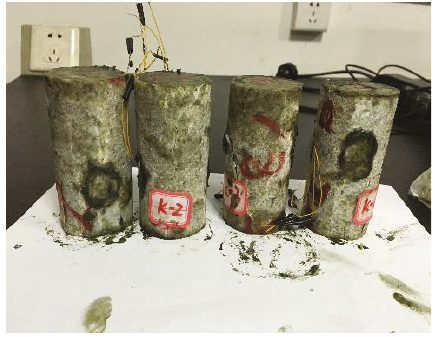
Figure 5: Part of the ore sample failure